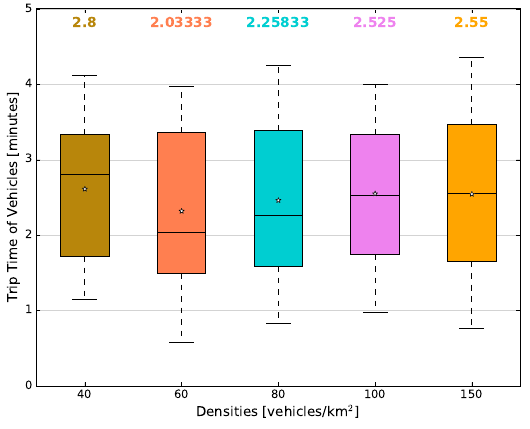
Figure 14. Average trip time of vehicles vs. densities.